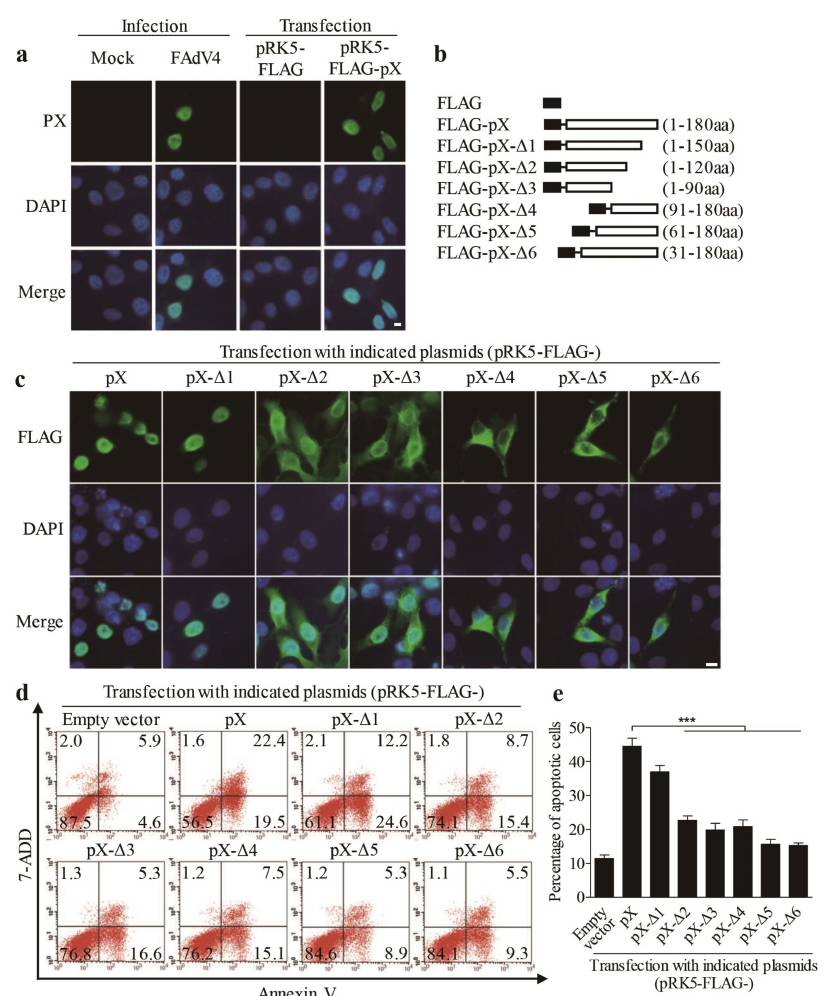
Figure 3. Localization of PX in the nucleus is required for PX-induced apoptosis. ( a ) LMH cells were seeded on 12-well plates and cultured overnight, followed by infection with FAdV4 at a MOI of 1 or transfected with pRK5-FLAG-pX at 1 µ g per well. Twenty-four hours after treatment, cells were fixed and probed with an anti-PX monoclonal antibody, followed by incubation with FITC-conjugated goat anti-mouse antibodies (green). Cell nuclei were counterstained with DAPI (blue). Cells were observed with a fluorescence microscope. The scale bar represents 10 µ m. ( b ) Schematics represent the genes encoding the full-length or truncated PX molecules (from ∆ 1 to ∆ 6). ( c ) Distribution of PX or PX-truncated mutants in LMN cells. LMH cells were transfected with indicated plasmids as described in ( a ). Twenty-four hours after transfection, cells were fixed and probed with mouse anti-FLAG antibodies, followed by incubation with FITC-conjugated goat anti-mouse secondary antibodies (green). Cell nuclei were counterstained with DAPI (blue). LMH cells were observed with a fluorescence microscope. The scale bar represents 10 µ m. ( d , e ) Examination of apoptosis in LMH cells expressing PX or PX-truncated mutants. LMH cells were transfected with indicated plasmids as described above. Forty-eight hours after transfection, cells were harvested, stained with Annexin V-PE and 7-AAD, and analyzed by flow cytometry ( d ). The percentage of apoptotic cells in ( d ) was quantified and shown in ( e ). Results are representative of three independent experiments. Data are presented as mean ± SD, n = 3. The significance of the di ff erences between the groups was performed by one-way ANOVA (*** stands for p <